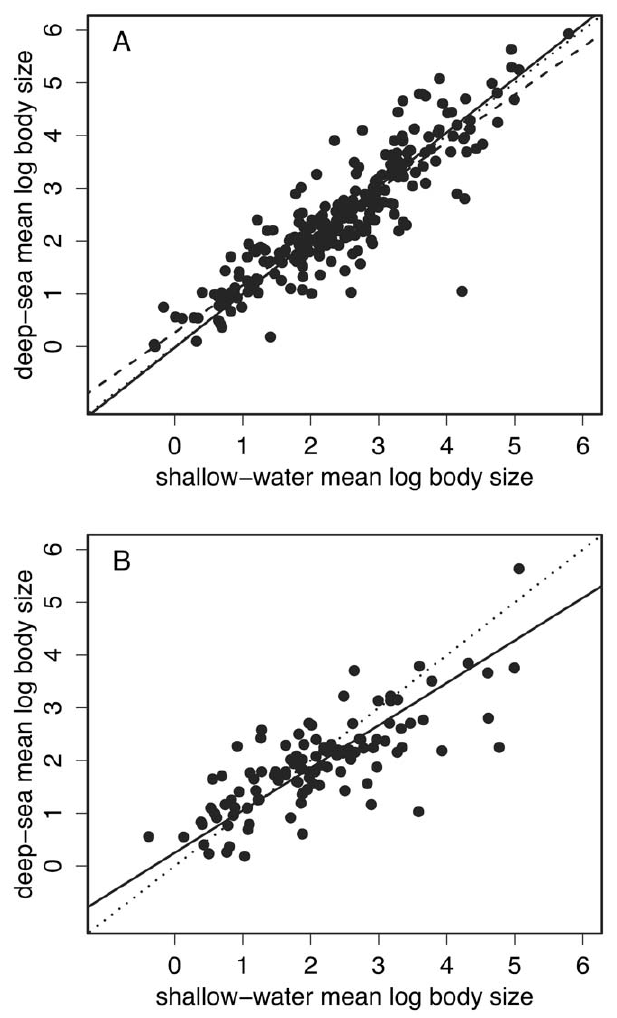
Figure 1. Body sizes of deep-sea gastropods and their shallow- water congeners. Part A shows how different tests of the ‘island rule’ can give qualitatively different results. ‘‘Deep-sea’’ species were defined as those with a depth range midpoint . 200m, and all other species defined as ‘‘shallow-water’’. The ordinary-least-squares regression (dashed line) differs significantly from the 1:1 line of the null (dotted line), but the standardized-major-axis regression (solid line) shows no significant departure. Part B shows a less ambiguous case: ‘‘deep-sea’’ species are those never observed above 400m, and ‘‘shallow-water’’ species those never observed below 200m; body sizes are within-genus means, taking equal numbers of deep- and shallow-water species in each